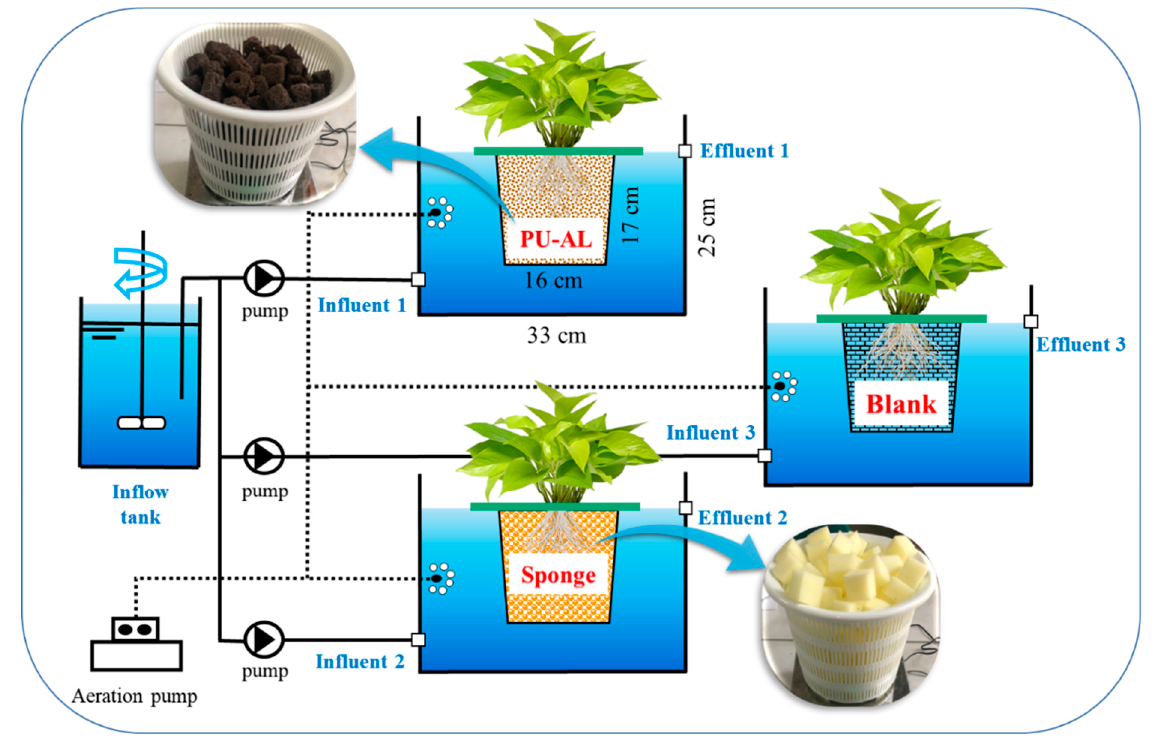
Figure 4. Configuration of the experimental system.